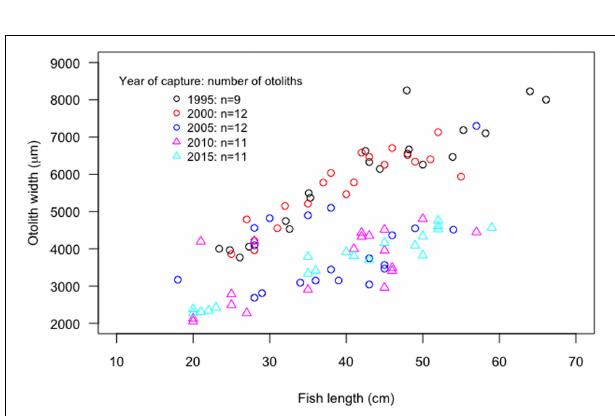
FIGURE 9 | The ratio between otolith width (OW) and fish length (FL) by the year of capture.